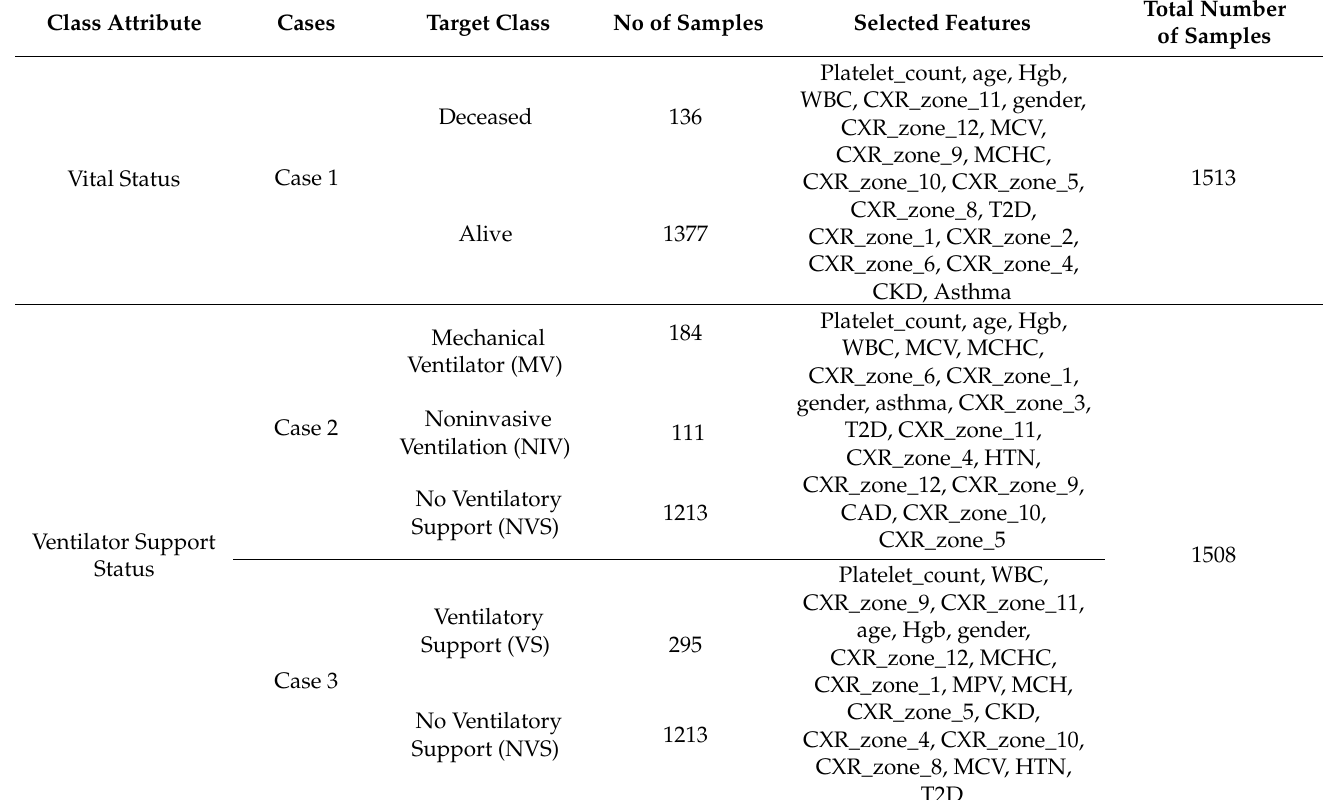
Table 1. Distribution of patient samples per category for cases 1, 2, and